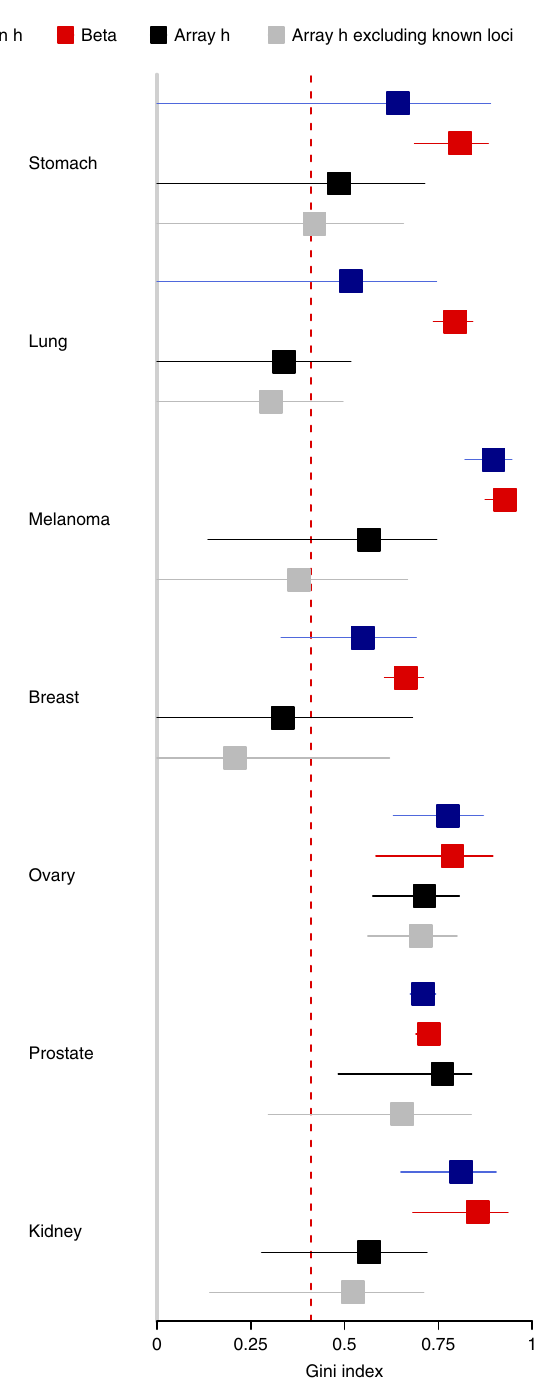
Fig. 6 Comparing Gini indices from different risk distributions. The Gini indices with 95% con fi dence intervals displayed in Figs. 2, 4 and 5 are shown together. Only the cancers that were reported in both Mucci et al. 20 and Lu et al. 29 are included. The red dashed line marks the Gini index